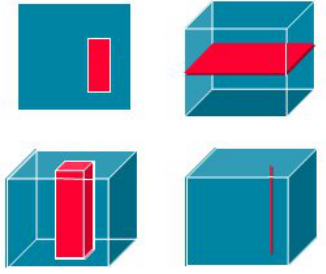
Figure 2. Trimming ( left ) and slicing ( right ) (source: